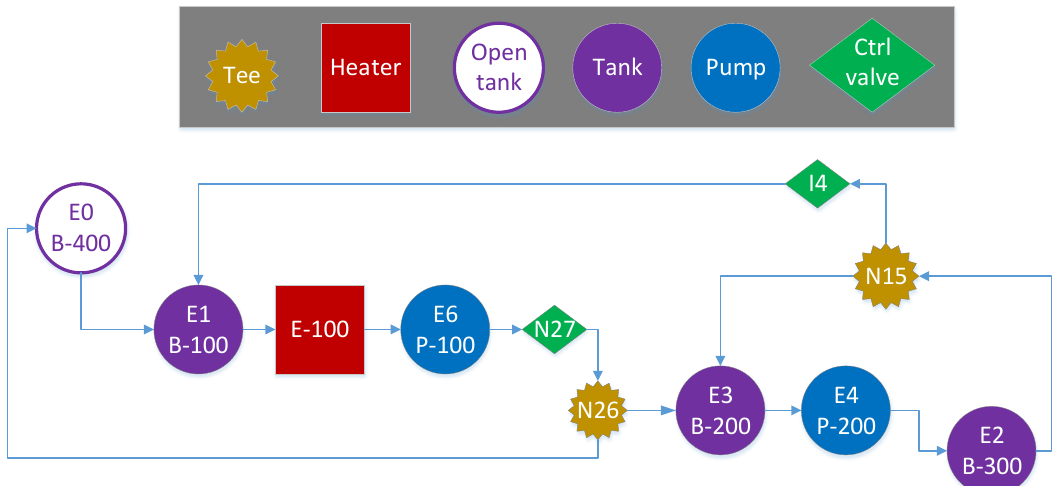
Figure 12. The result of processing the graph in Figure 11 with the algorithm in Figure 4. The tank with an internal heater is presented by adding the heater to the outgoing flow of the tank.